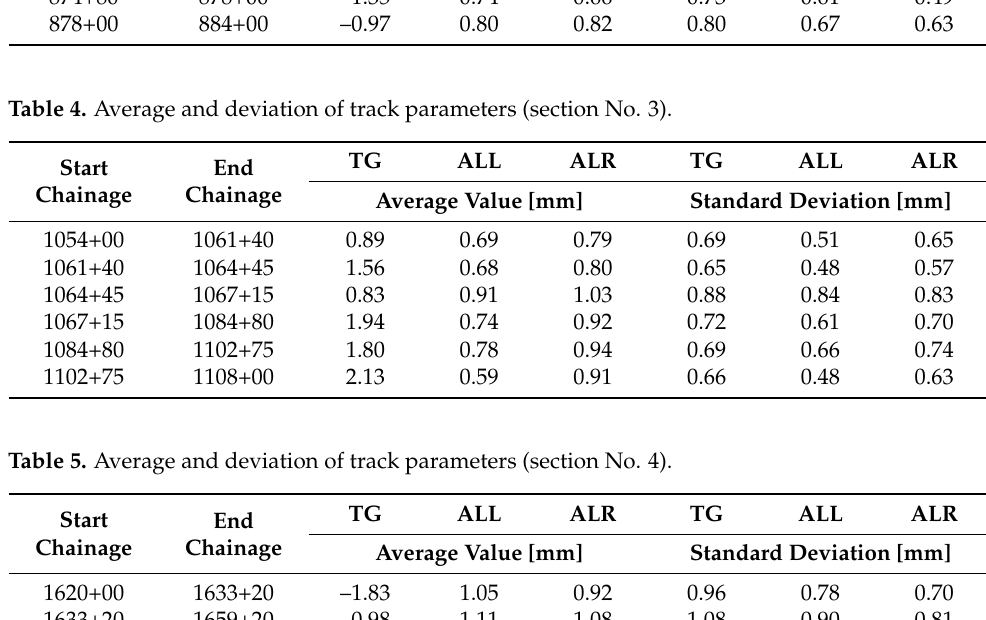
Table 4. Average and deviation of track parameters (section No. 3).